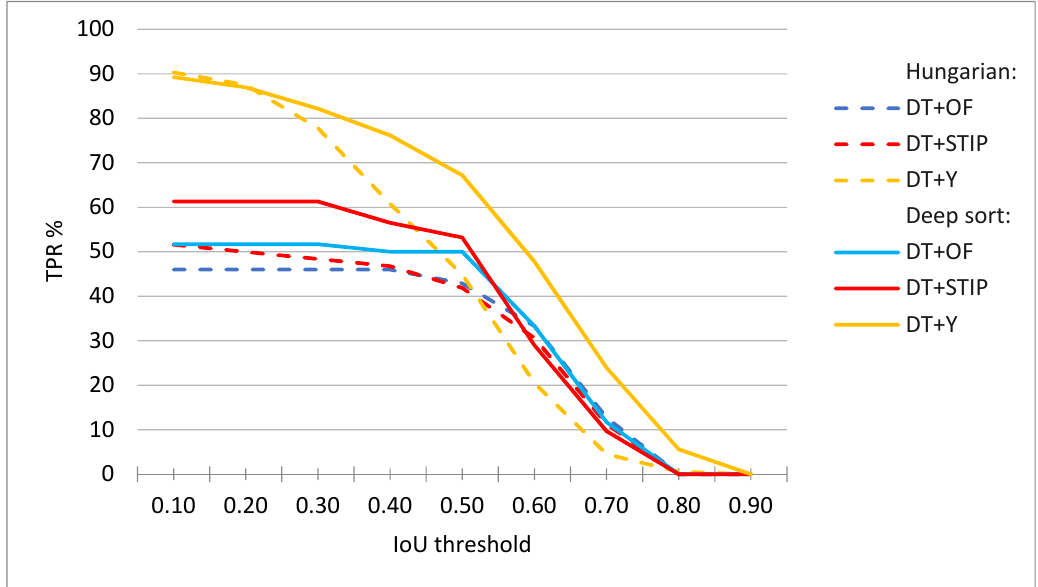
Figure 15. Evaluation results for player tracks obtained with DT+OF, DT+STIP, and DT+Y activity measures using Deep sort or Hungarian algorithm for tracking. The results at minimum θ = 50% correct frames per sequence.